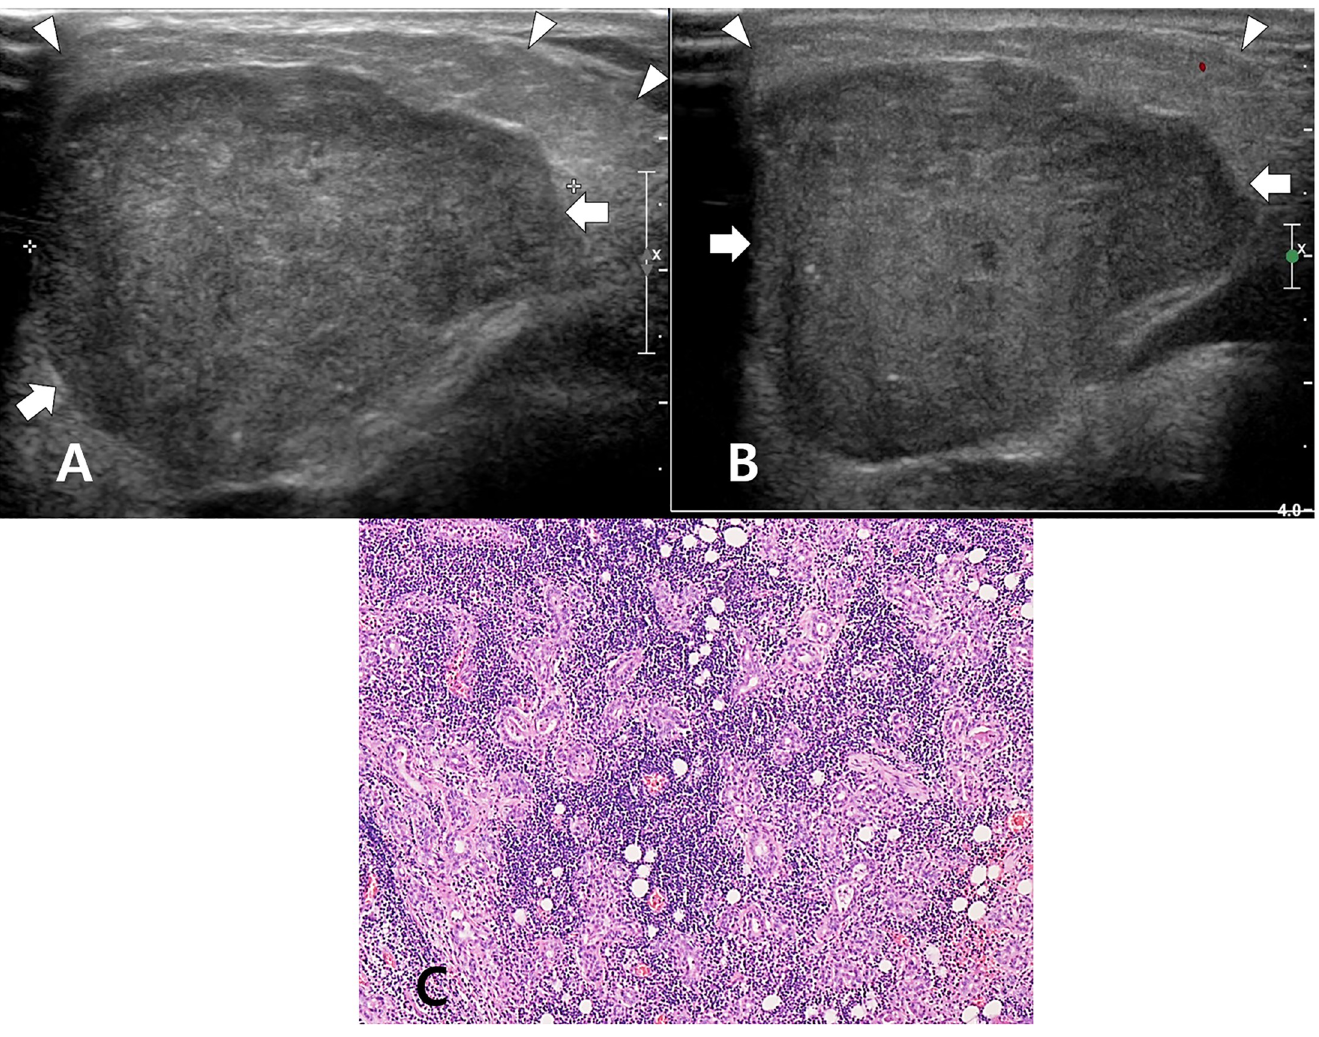
Fig 2. A 55-year-old man with category 3 on US and autoimmune parotitis in histopathology. On the longitudinal gray-scale sonogram (A), a benign mixed tumor (arrows) in the right parotid gland is observed, and the right parotid gland (arrowheads) shows decreased parenchymal echogenicity, coarse parenchymal echotexture, normal gland size, and a smooth margin. On the longitudinal color Doppler sonogram (B), normal parenchymal vascularity is observed. In the histology slide (C), marked loss of glandular acini and dilated ducts surrounded by dense lymphoid cells are noted (hematoxylin and eosin stain, × 100).